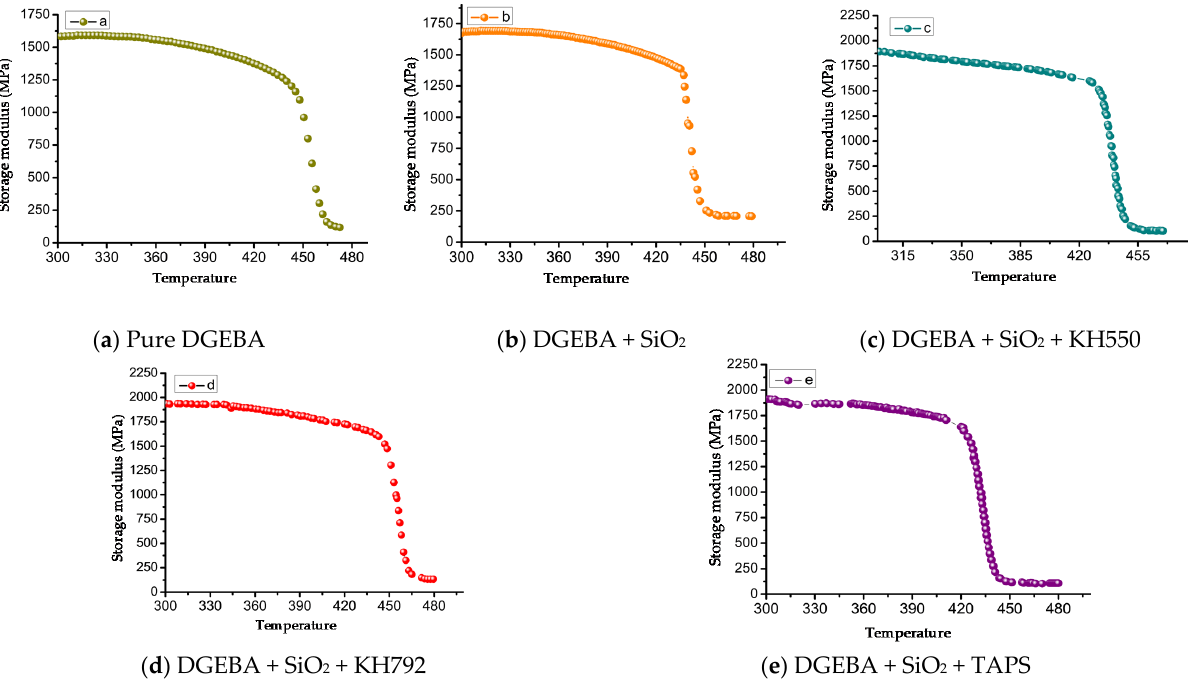
Figure 3. Storage modulus of five samples at the same temperature.